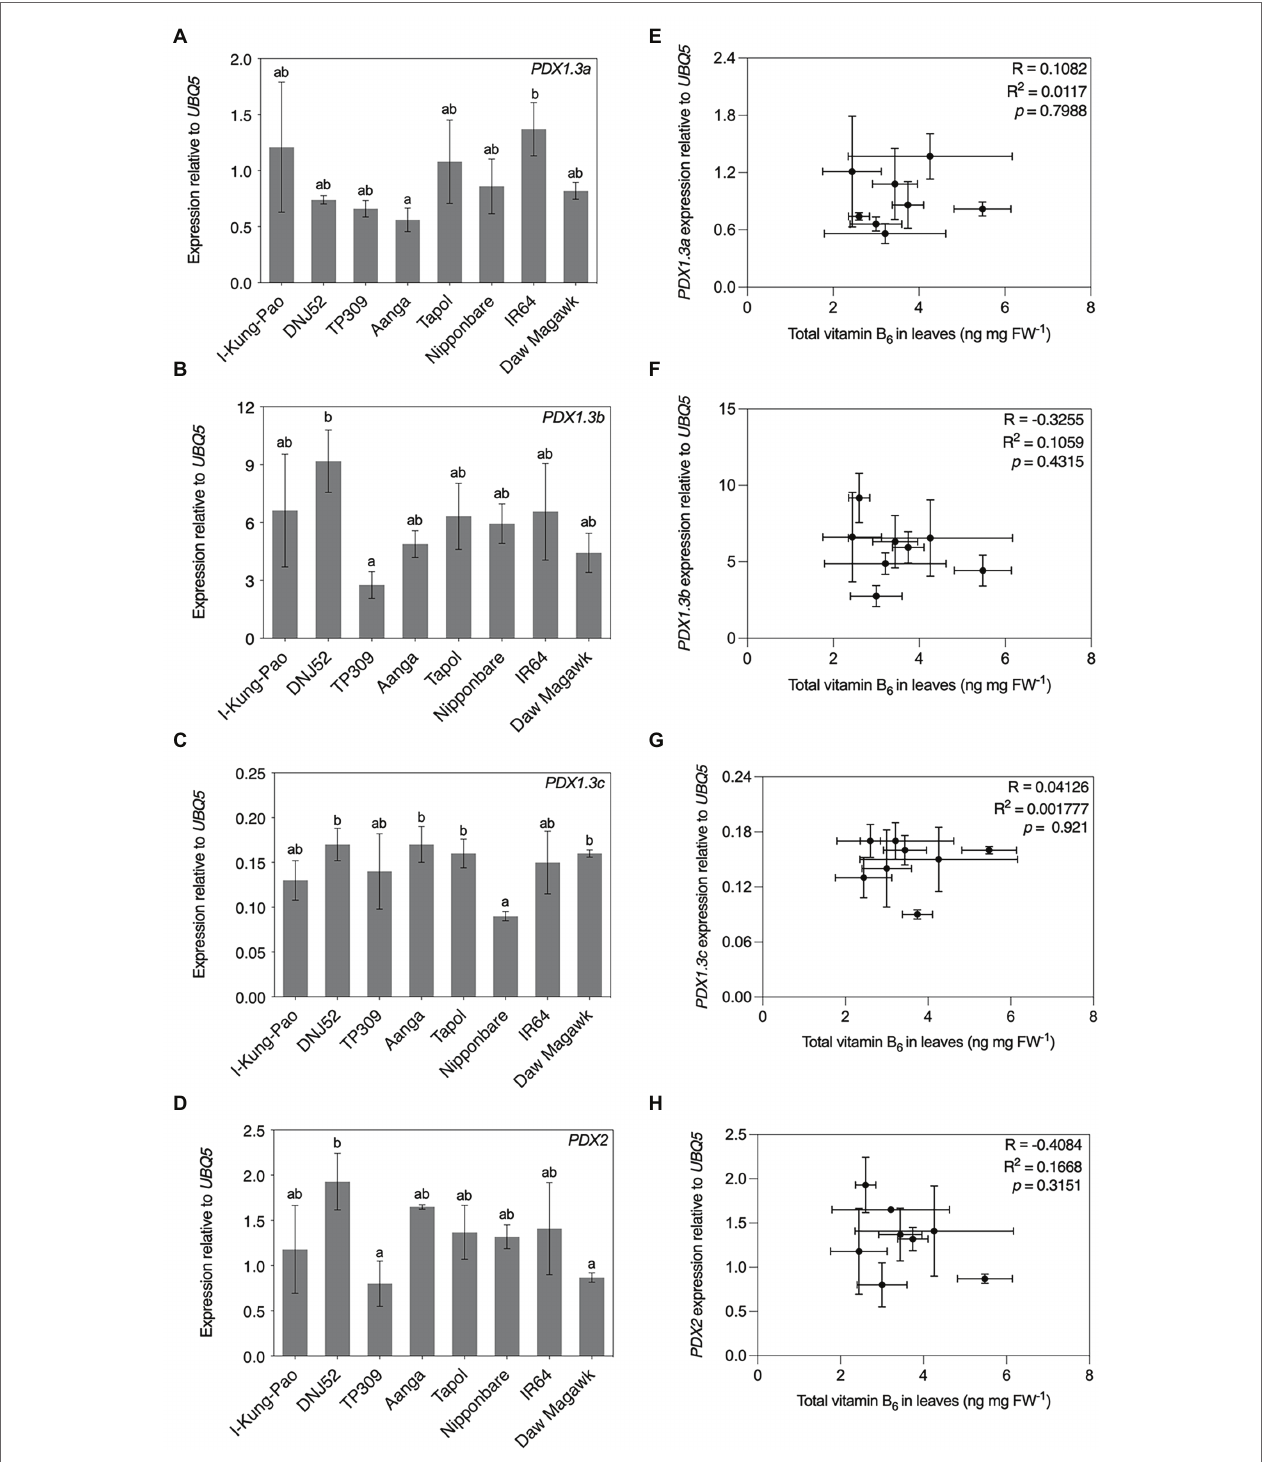
FIGURE 7 | Expression and correlation of select genes for vitamin B 6 biosynthesis de novo enzymes in leaves of accessions with contrasting vitamin B 6 contents. RNA was isolated from plant material used in Figure 5B for qRT-PCR assays of PDX1.3a (A) , PDX1.3b (B) , PDX1.3c (C) , and PDX2 (D) expression. Expression was normalized to UBQ5 and data are the mean ± standard deviation of n = 3 biological replicates. Accessions are ordered according to leaf total vitamin B 6 content as determined in Figure 5B . The effect of accession on gene expression was determined by one-way ANOVA ( α = 0.05) with multiple comparisons and Tukey’s post- hoc test. Statistically significant differences between accessions are denoted by different letters. Correlation of PDX1.3a (E) , PDX1.3b (F) , PDX1.3c (G) , and PDX2 (H) gene expression from panels (A–D) , respectively, with leaf total vitamin B 6 contents in Figure 3B by Pearson’s correlation coefficient test ( p <